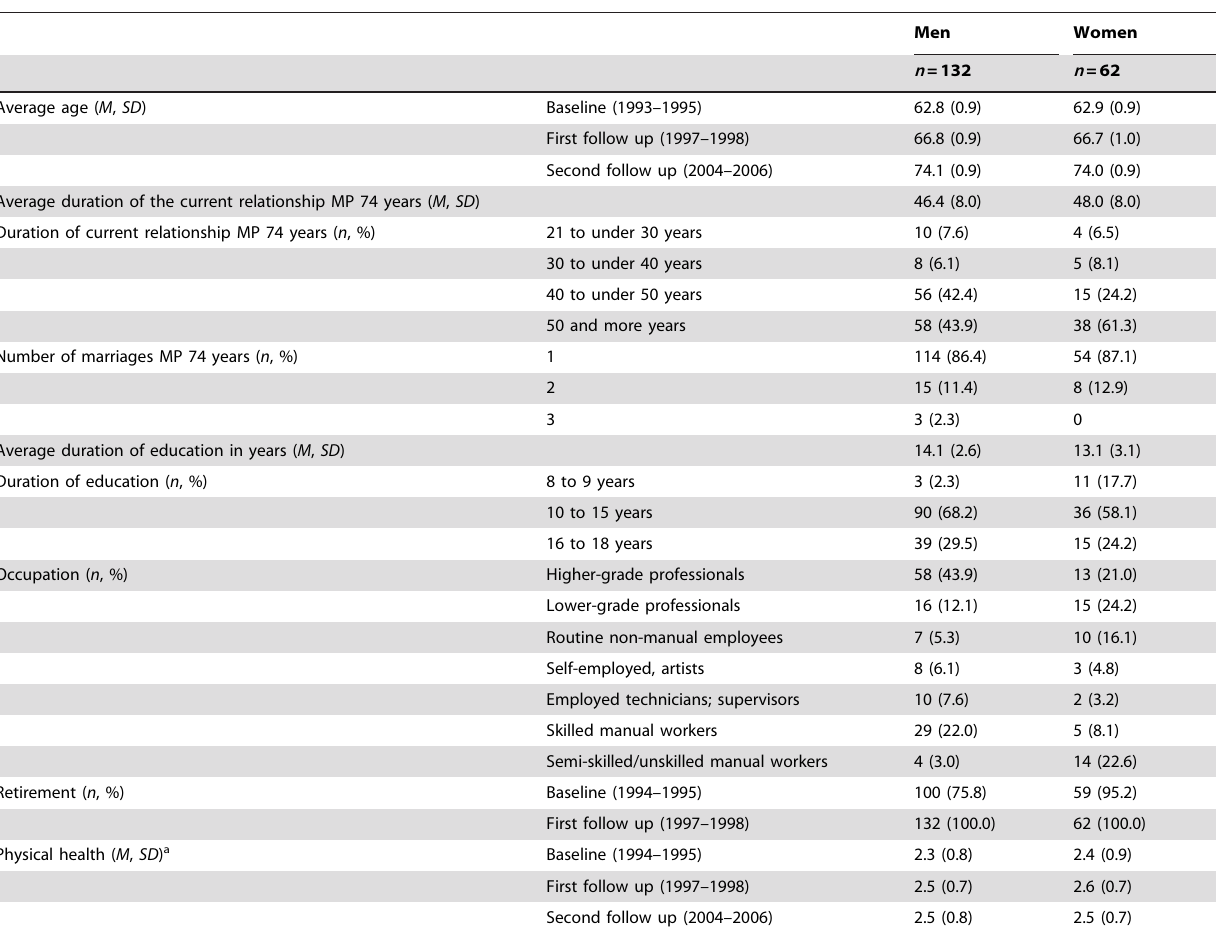
Table 1. Characteristics of